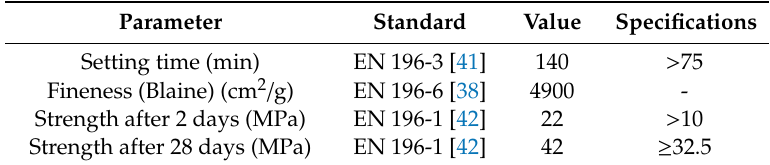
Table 4. Portland cement characteristics.